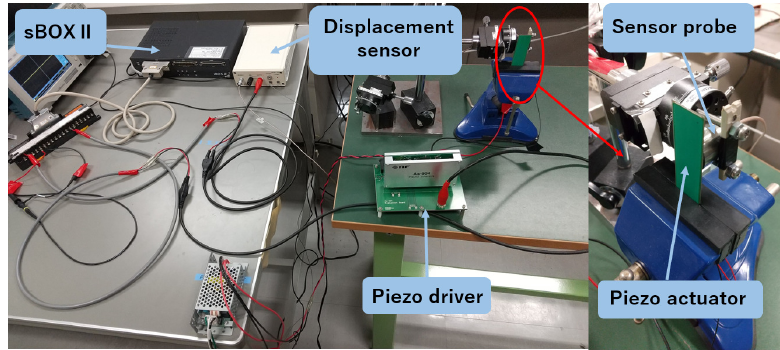
Figure 12. The experimental